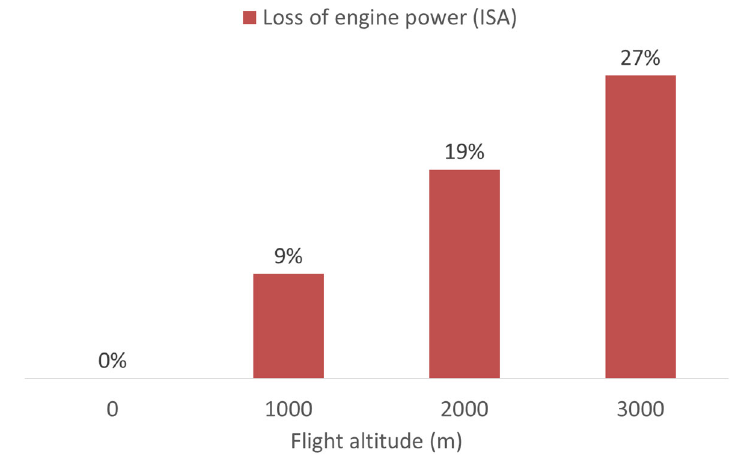
Figure 8. Loss of engine power as a function of flight altitude.